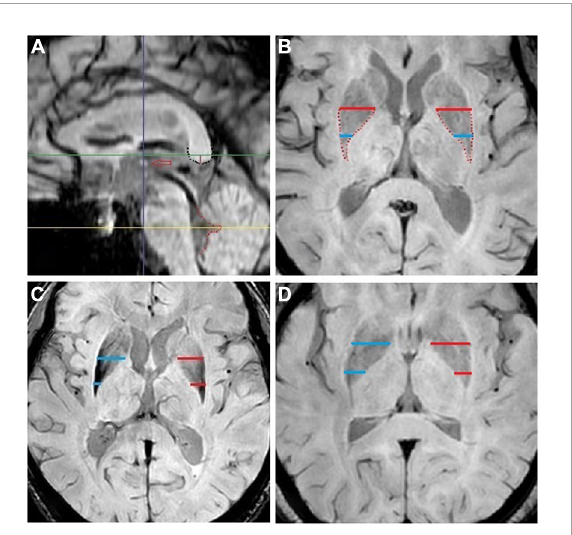
FIGURE1 (A) Standard midsagittal plane. The thalamic syndesmosis (hollow red arrow), corpus callosum splenium (black dot) and 4th ventricle posterior edge (red dot). The parallel horizontal green and yellow line define the axis plane selection for lentiform nucleus and cerebrospinal fluid measurements: the green line is set at 3.5 mm (red vertical line) above the black dot, and the yellow line is set to cross the cusp of the red dot. The vertical blue line defines the anterior-posterior location of the lentiform nucleus short line and is set to cross the middle of thalamic syndesmosis. (B) Standard axis plane for lentiform nucleus measurement. The blue and red lines are used for the short and long lines of the lentiform nucleus measurement: the red line is the longest line near the middle area of the lentiform nucleus, and the blue line is defined by the vertical blue line in a. (C) F, 59, patient with probable multiple system atrophy-parkinsonian subtype with general weakness for 1 year, obviously in her lower limbs, walking drag, dizziness for 2 months, and turning over difficulty for 1 month. (D) F, 60, patient with Parkinson disease with an inflexible right upper limb for 2 years, right lower limb shake for 1 year, and the right upper limb shake for more than 2 months. The slice selection and measurement protocols were assigned according to our previous study. The smaller short line side (blue line in panel C and red line in panel D ) was recorded as corrected short line (cSL), and the corrected ratio (cSLLr) was calculated using the long line with the same cSL